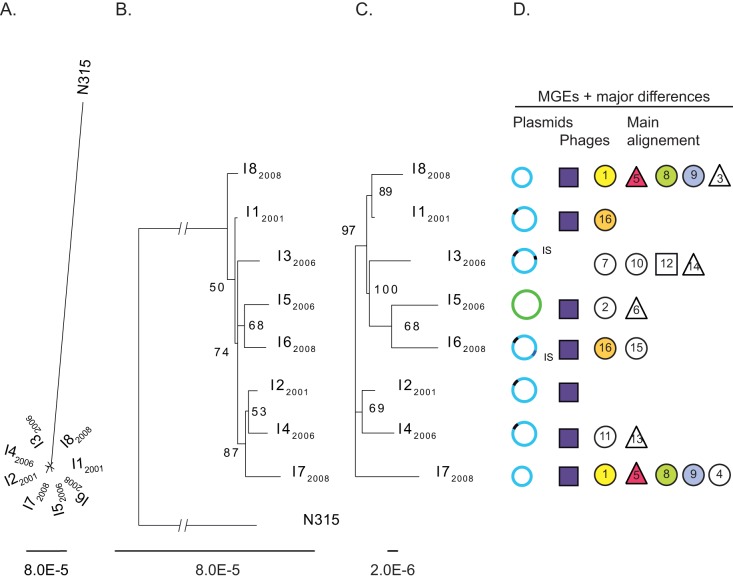
RaxML phylogeny based on the SNPs obtained after the alignment of the core genome.A. In this analysis, the strain N315 was included and used as outgroup. B. Same analysis as in A with bootstrap values given for each node. Nodes that were under the 50% majority rule were collapsed. The tree was rooted with N315 but the distance between this strain and the other was shortened to focus on the relationships between the eight isolates. C. Phylogeny based on the SNPs of the core genome based on the comparison of the eight isolates. D. Mapping of the MGEs and major differences observed between the different isolates onto the phylogenetic tree. Plasmids are represented by circle. The light blue and green circles represent the plasmids that are closely related to the published plasmid SAP064A and pUSA03, respectively. The black trait at the left side of the plasmids represents the presence of the mercuric operon whereas those on the right represent insertions of IS elements. The purple square illustrates the presence of an element of phage of about 18’500 bp. The smaller symbols describe the genetic variations described in Table 2. Circles were used for deletions, triangles for insertions and squares for other types of modifications. The numbers within each symbol correspond to the genetic variation described in Table 2. The symbols are white when the difference is unique to one isolate and colored when it is shared between different isolates.